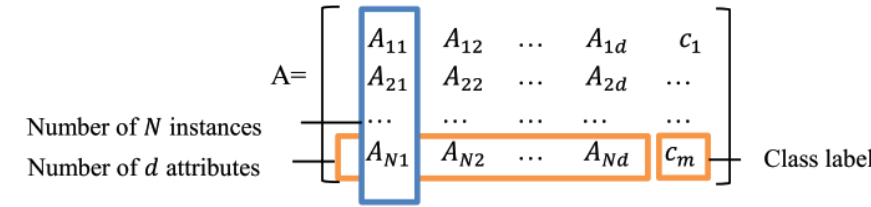
Figure 1. An example of a dataset with features .